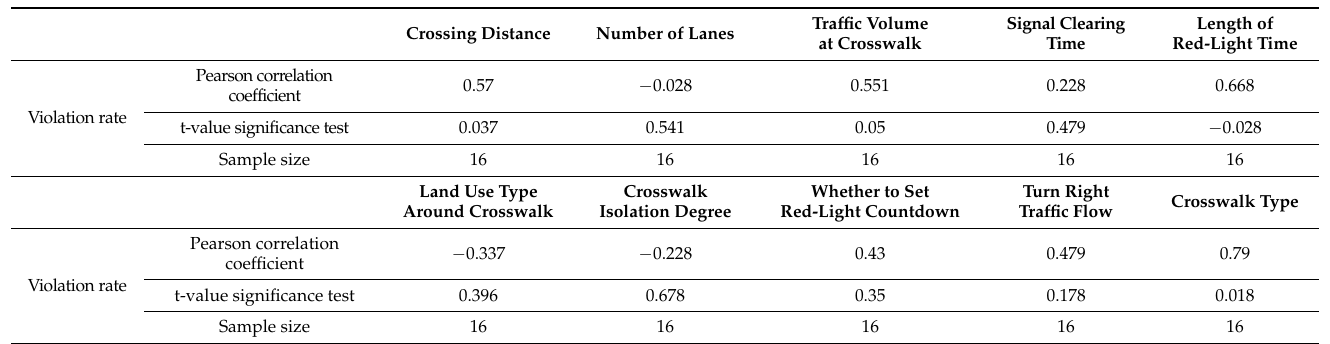
Table 2. Correlation analysis between risk factors and violation